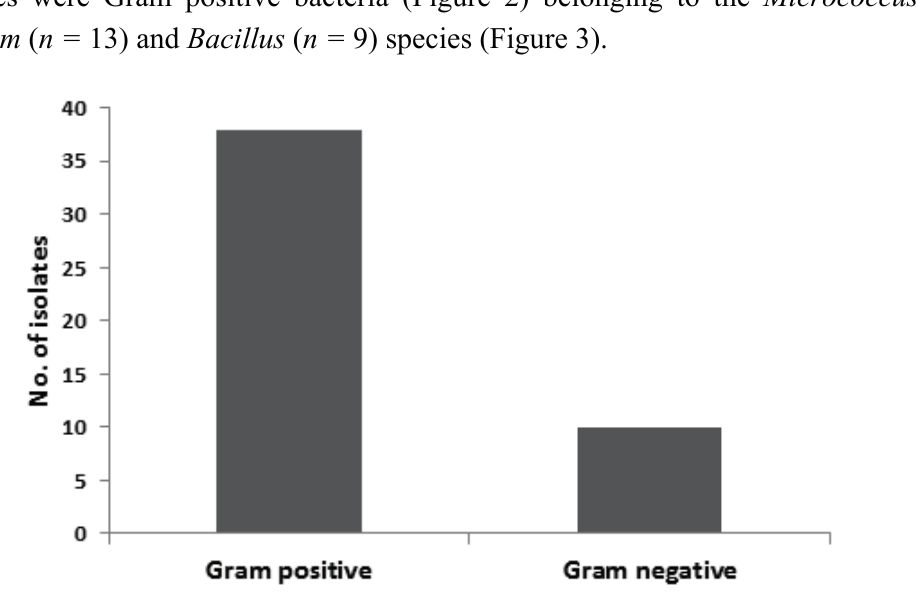
Figure 2. Distribution of bacterial isolates based on Gram stain.